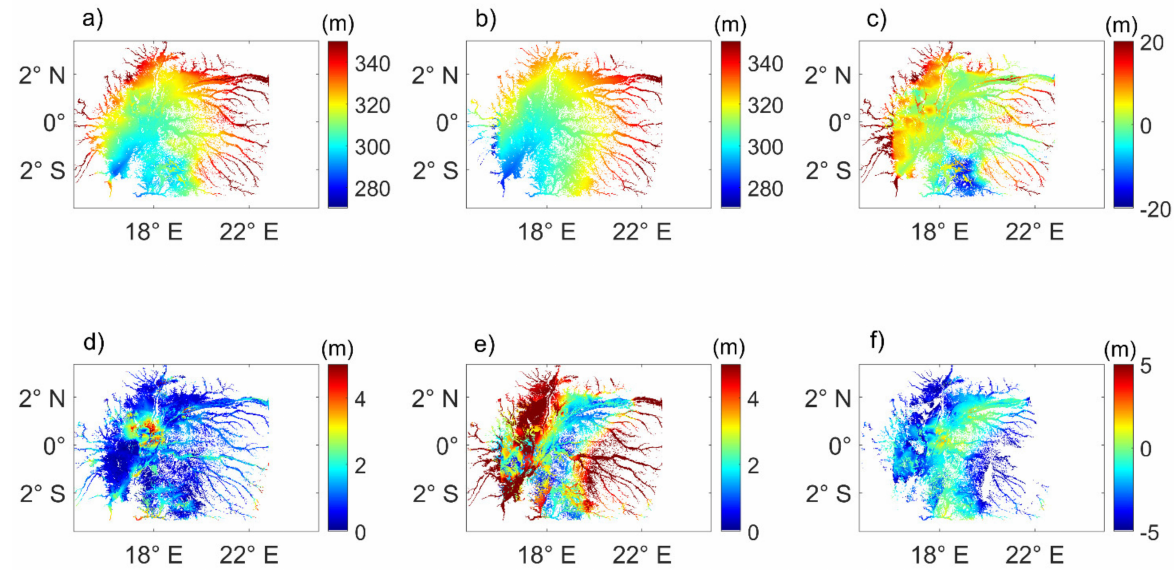
Figure 10. Maps of minimum of height from ENVISAT based on the VSs ( a ) automatically created over the rivers and the floodplains or ( b ) manually created over the rivers and made available by Hydroweb, and ( c ) their difference. Maps of mean annual amplitude using the VSs ( d ) over the rivers and floodplains, ( e ) only over the rivers, and ( f ) their